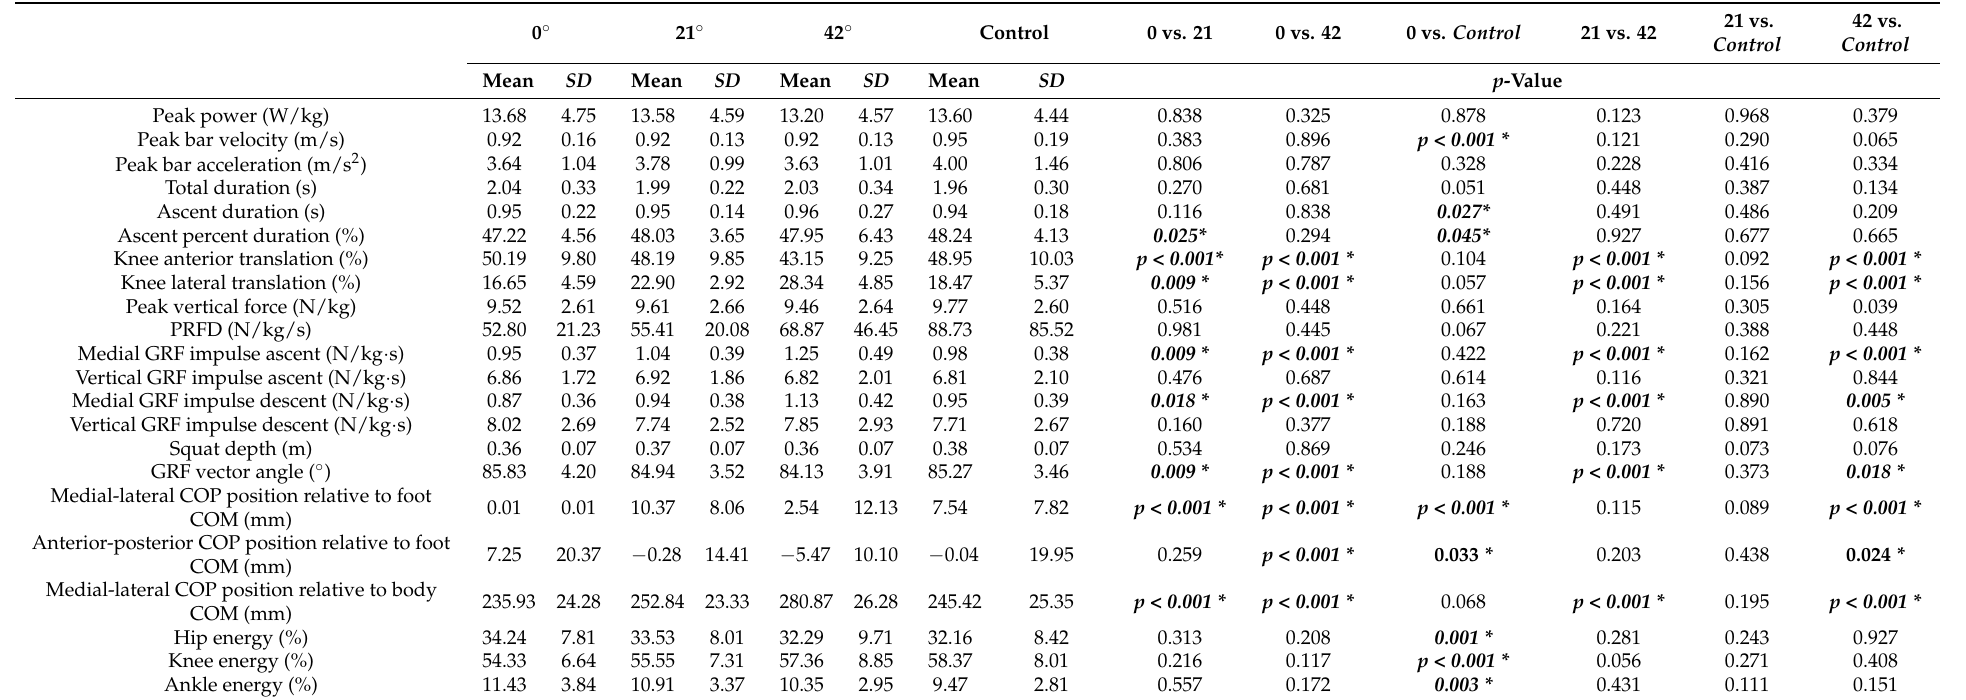
Table 5. Kinetic and temporal parameters (mean ± SD) and statistical comparisons as a function of each experimental